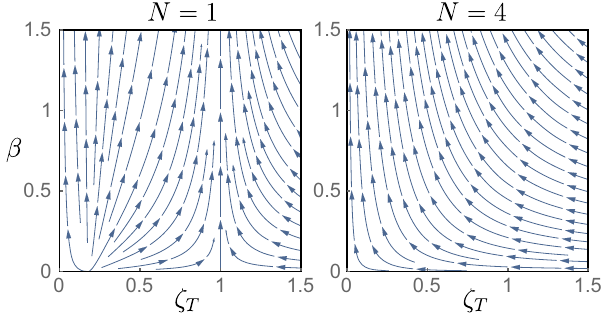
FIG. 4. The RG flow of the dimensionless electron-phonon coupling β and the velocity ratio ζ T given by Eq. (17) for a single Dirac cone (left) and for N ¼ 4 (right). In both cases, the flow is towards strong coupling, where the one-loop RG analysis breaks